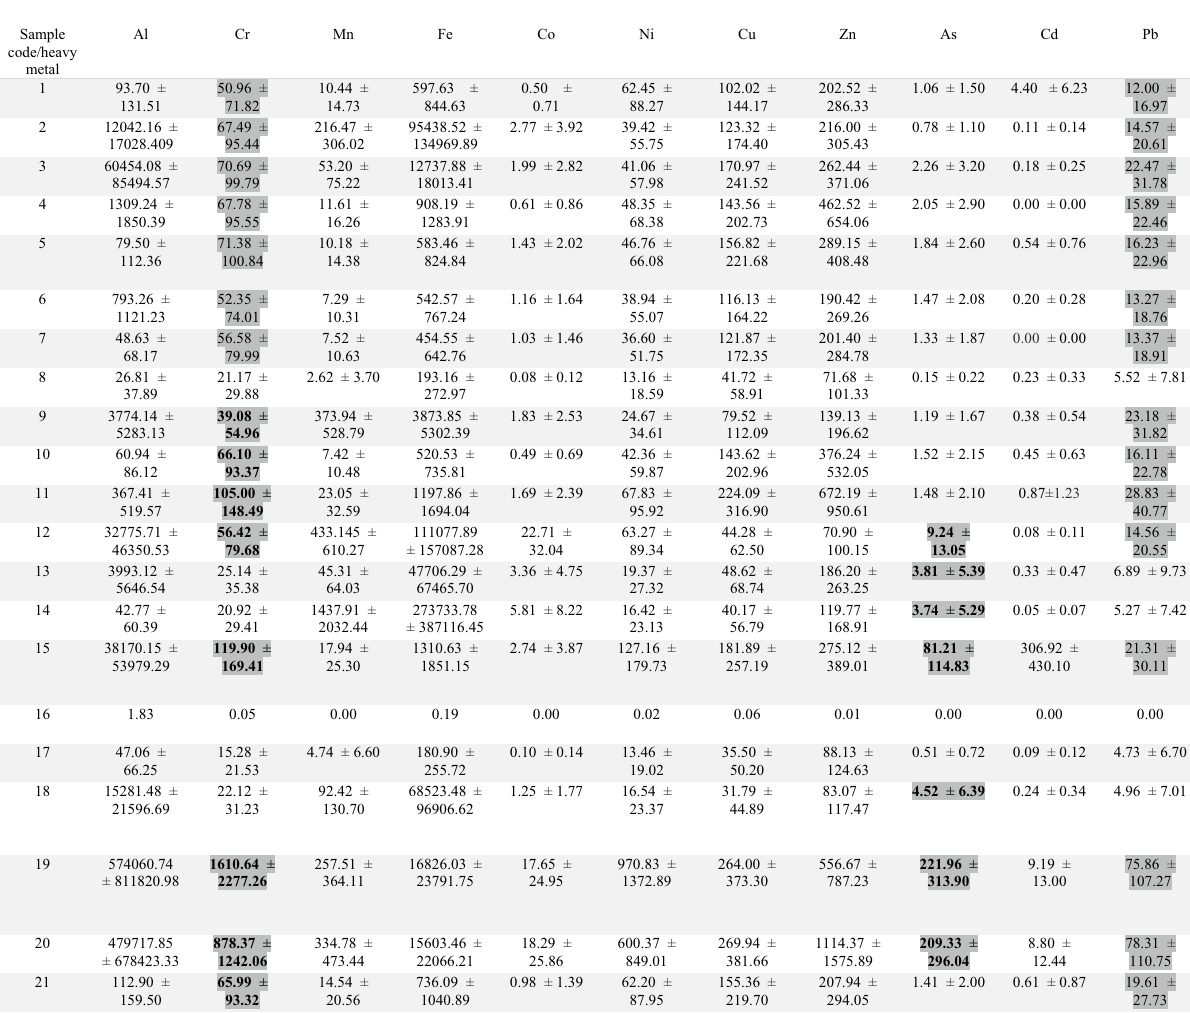
Table 4. Heavy metal concentrations in ppm (mean ± SD) detected in the tested cosmetic products. *Bolded and labeled in gray are the products that exceeded the US FDA